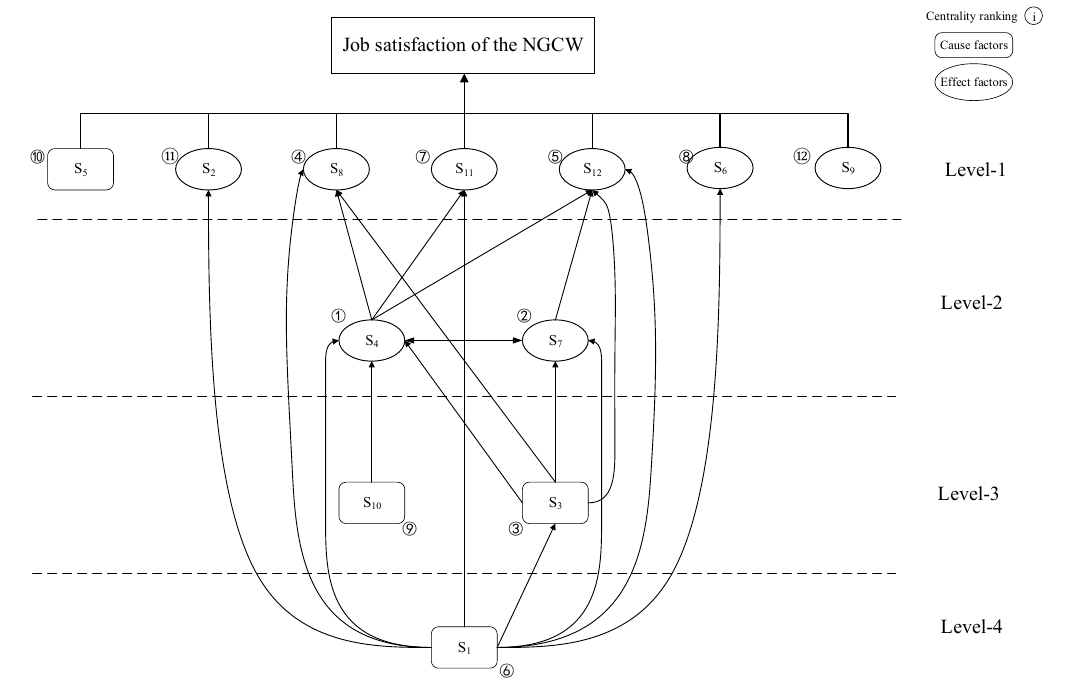
Figure 5. Combined DEMATEL-ISM model.